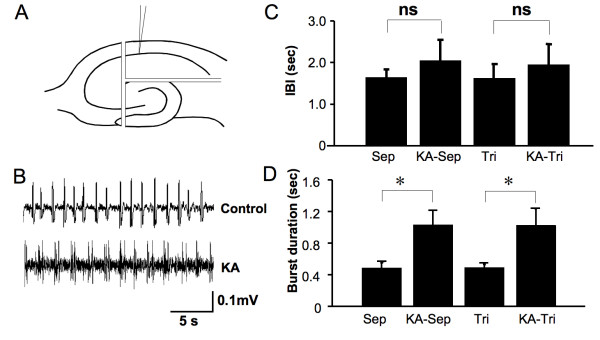
Isolated CA1 region slices behave identically to CA1/DG slices, ruling out an influence of DG on CA1 region excitability following a KA insult. (A) Cartoon showing the surgical separation of CA1. (B) Synchronized neuronal firing under Mg2+-free conditions in a slice following separation. (C) IBI of synchronized events in CA1 following separation and trisectioning (mean ± SEM, n = 6, one-way ANOVA). (D) Burst duration in CA1 following separation (mean ± SEM, * = p < 0.05, ns = p > 0.05, n = 6, one-way ANOVA. Sep = CA3 separation/deafferentation, Tri = trisectioned to leave only CA1).